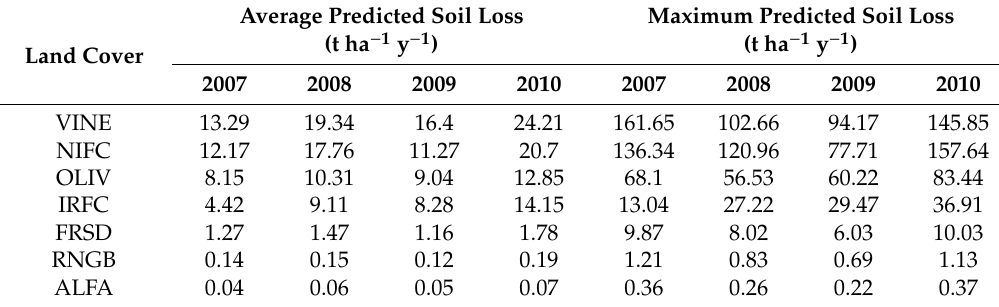
Table 6. Average and maximum predicted soil loss for each land cover and for each year. The land cover classes were as follows: meadow (ALFA); broad-leaved forest (FRSD); irrigated field crops (IRFC); unirrigated field crops (NIFC); olive groves (OLIV); transitional woodland-shrub-brush (RNGB); artificial surfaces (URBN); vineyards (VINE).